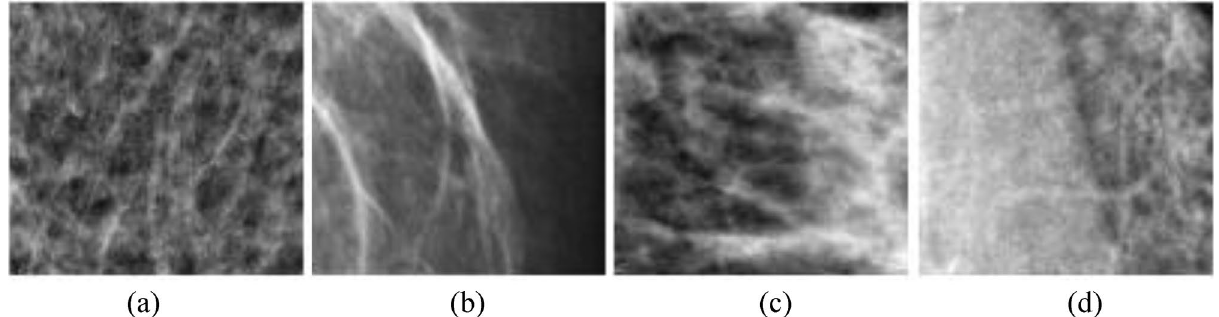
Figure 4. Samples of images to be extracted from combined datasets sourced from DDSM + CBIS and MIAS databases. Image labels: ( a ) mass abnormality (M); ( b ) calcification abnormality (CALC); ( c ) benign calcification (BC); and ( d ) benign with